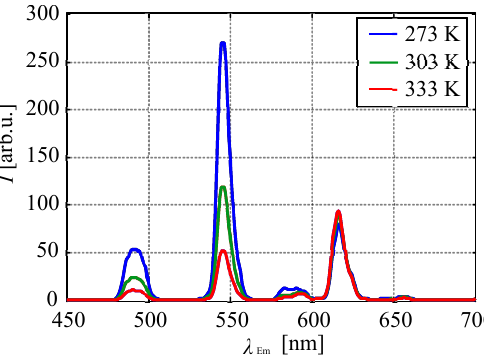
Figure 6. Effect of temperature on the emission spectrum of the chameleon luminophore in the